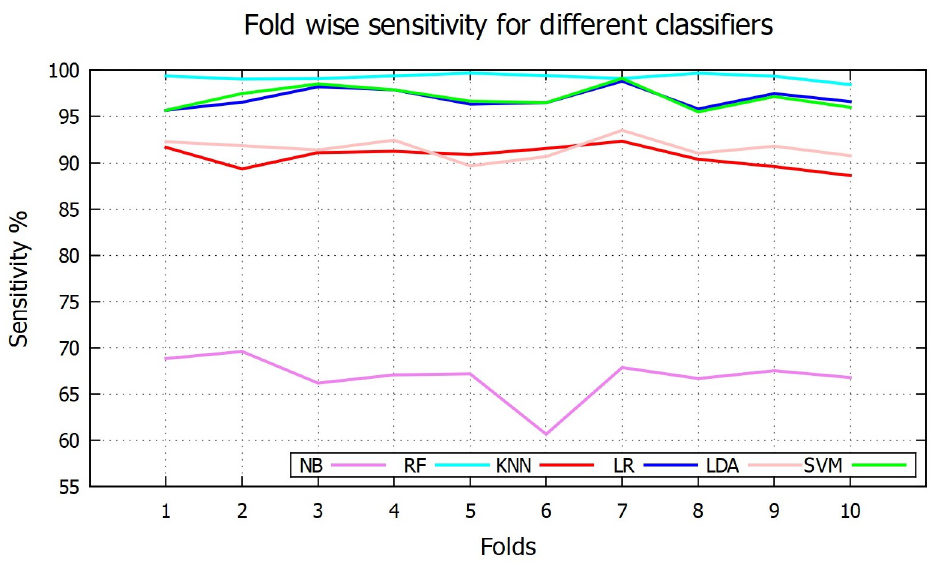
Fig 7. Fold wise sensitivity.